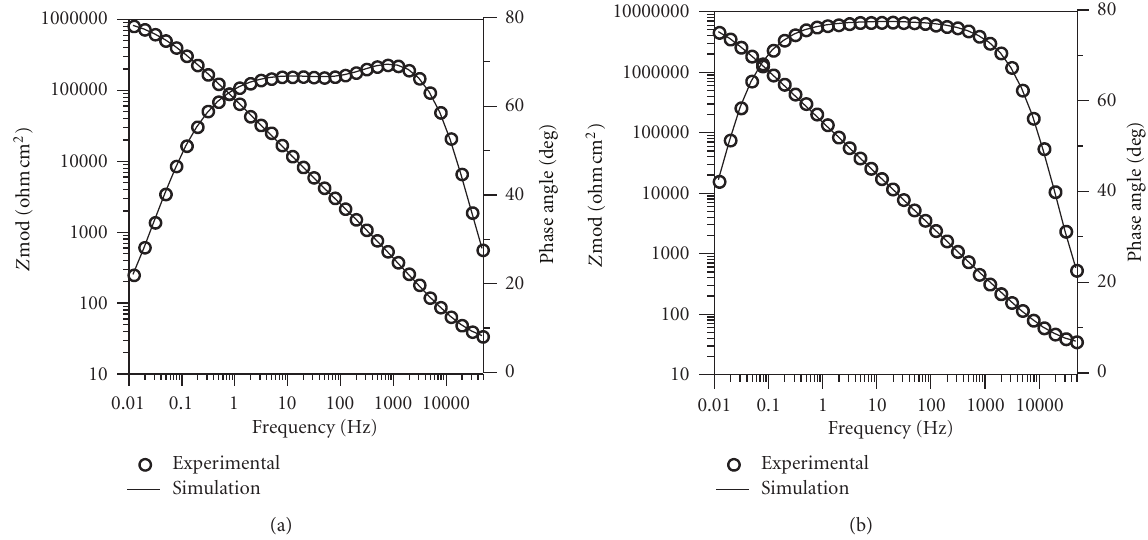
F 6: Bode plots for EIS data of NiTiNb alloy at (a) open circuit potential and (b) passive region.